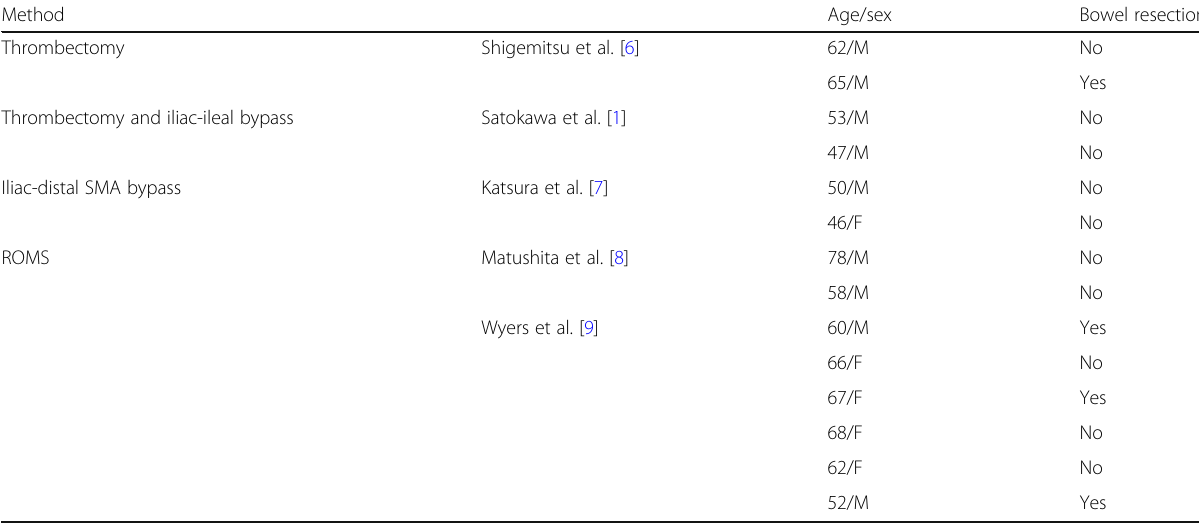
Table 1 Reported representative open treatment